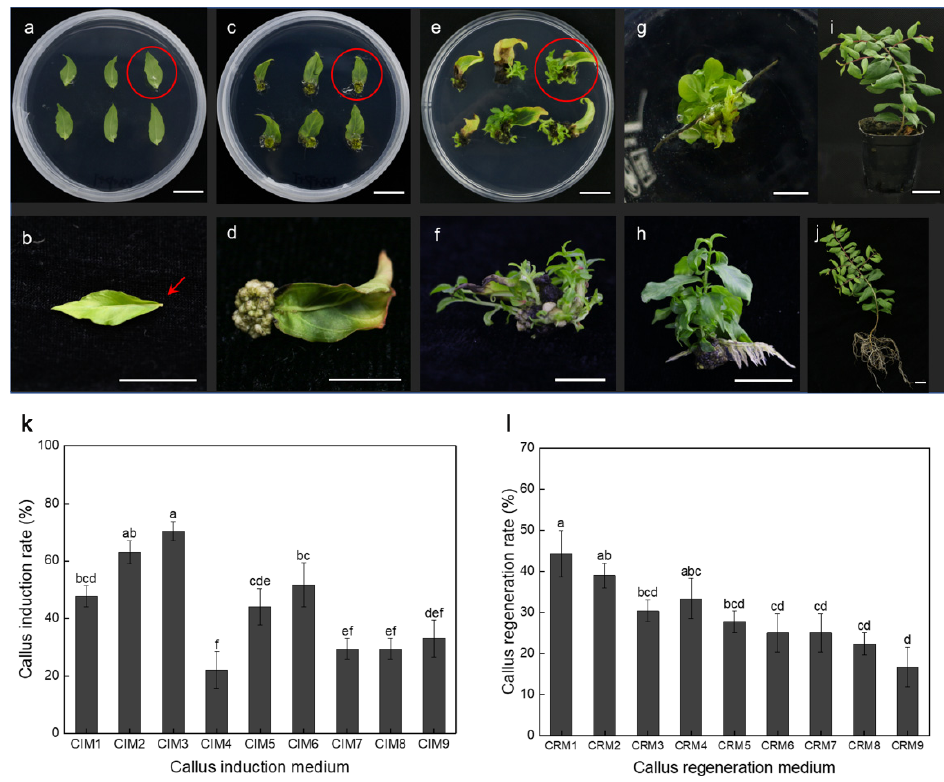
Figure 1. In vitro regeneration system of Lagerstroemia indica from whole leaf explants. ( a , b ) Whole-leaf explants for callus induction. ( c , d ) Induced callus from the whole-leaf explants. ( e , f ) Regeneration of shoots from the leaf calli. ( g , h ) Rooting of regenerated plantlets. ( i , j ) The rooted plantlets were acclimated to their environment, and then grown in the greenhouse. ( k ) Effects of cytokinin/auxin ratio on callus induction. ( l ) Effects of cytokinin/auxin ratio on callus regeneration. Scale bars = 1 cm ( a , c , e , g , i ), 2 cm ( b , d , f , h , j ). Different lowercase letters indicate significant differences at p < 0.05.